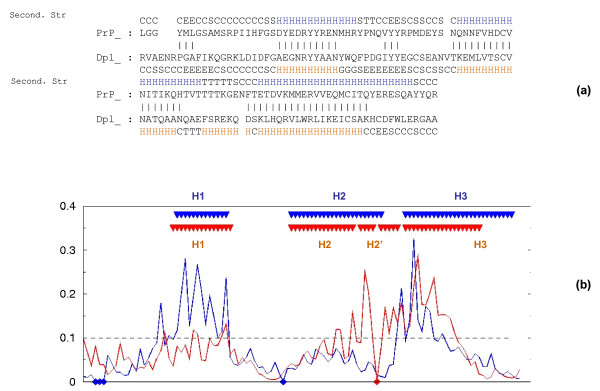
Structural alignment and rescaling of the principal eigenvectors. (a) Sequence alignment corresponding to the best structural alignment of the representatives of the most populated clusters for the simulations of PrP and Dpl at 310 K, obtained with the Sofist procedure. The RMSD of the aligned structures is 0.4 nm. (b) The components of the principal eigenvectors for PrP and Dpl rescaled and superimposed according to the optimal structural alignment.